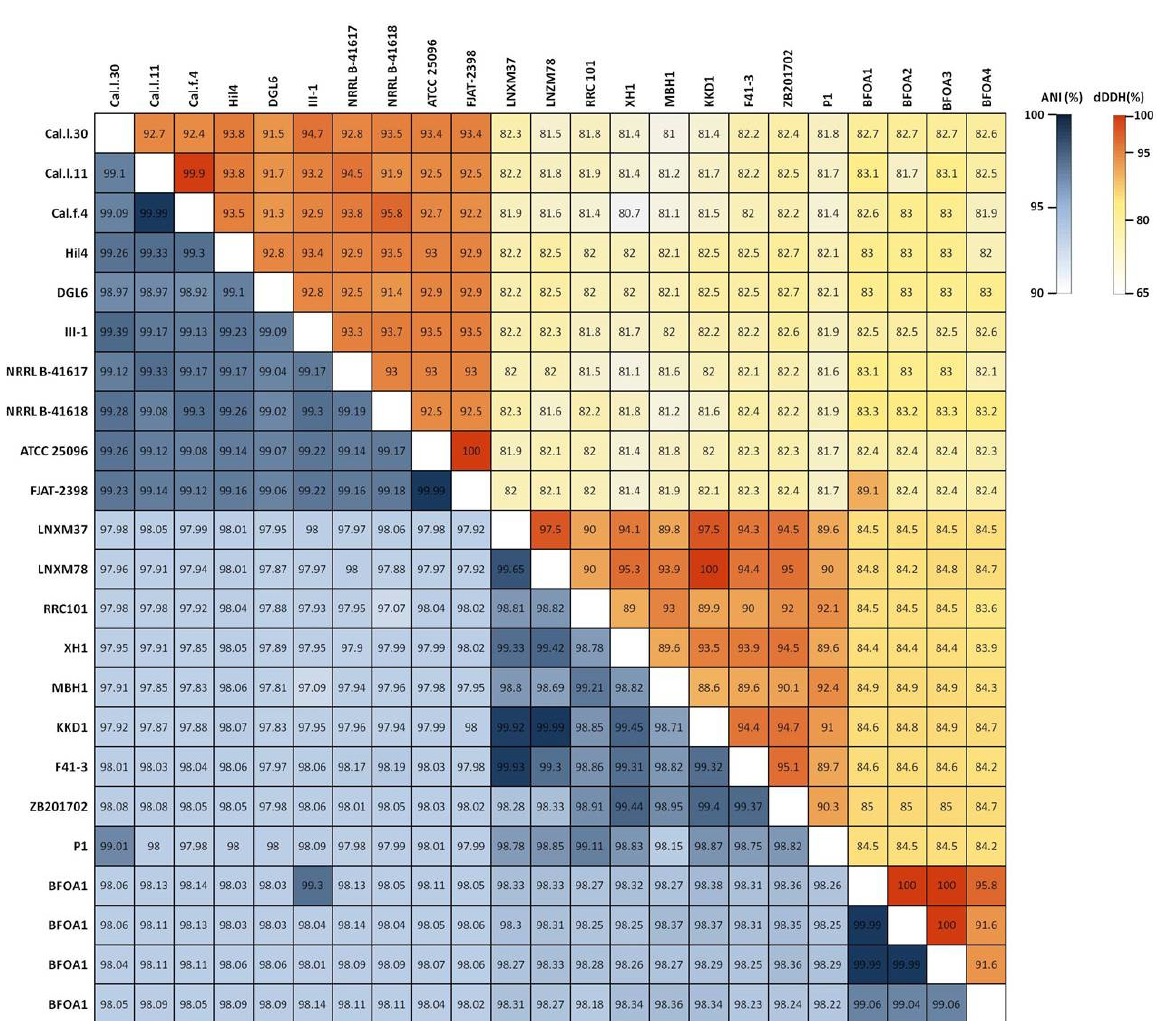
Table 1. Biosynthetic gene clusters (BGCs) involved in biosynthesis of secondary metabolites of bacterial strain B. halotol- erans Cal.l.30, detected by antiSMASH server.